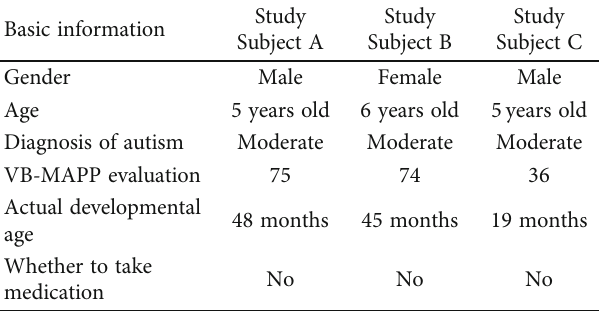
Table 1: Basic information of autistic children. Basic